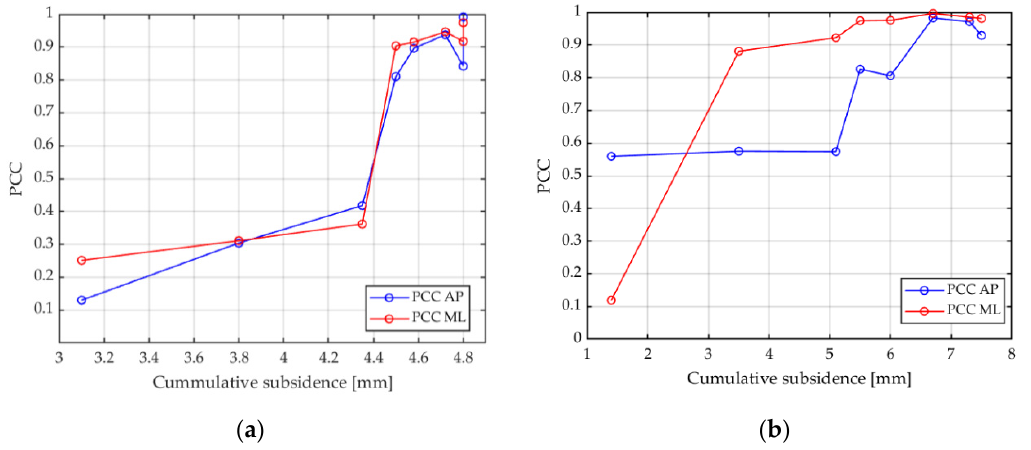
Figure A3. Pearson Correlation Coefficient development calculated in the 0–3.5 kHz range plotted against implant cumulative subsidence ( a ) without soft tissue ( b ) with soft tissue.